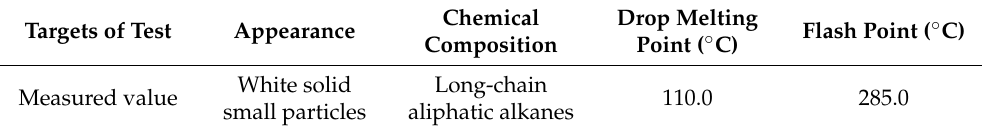
Table 2. Main technical indexes of Sasobit.